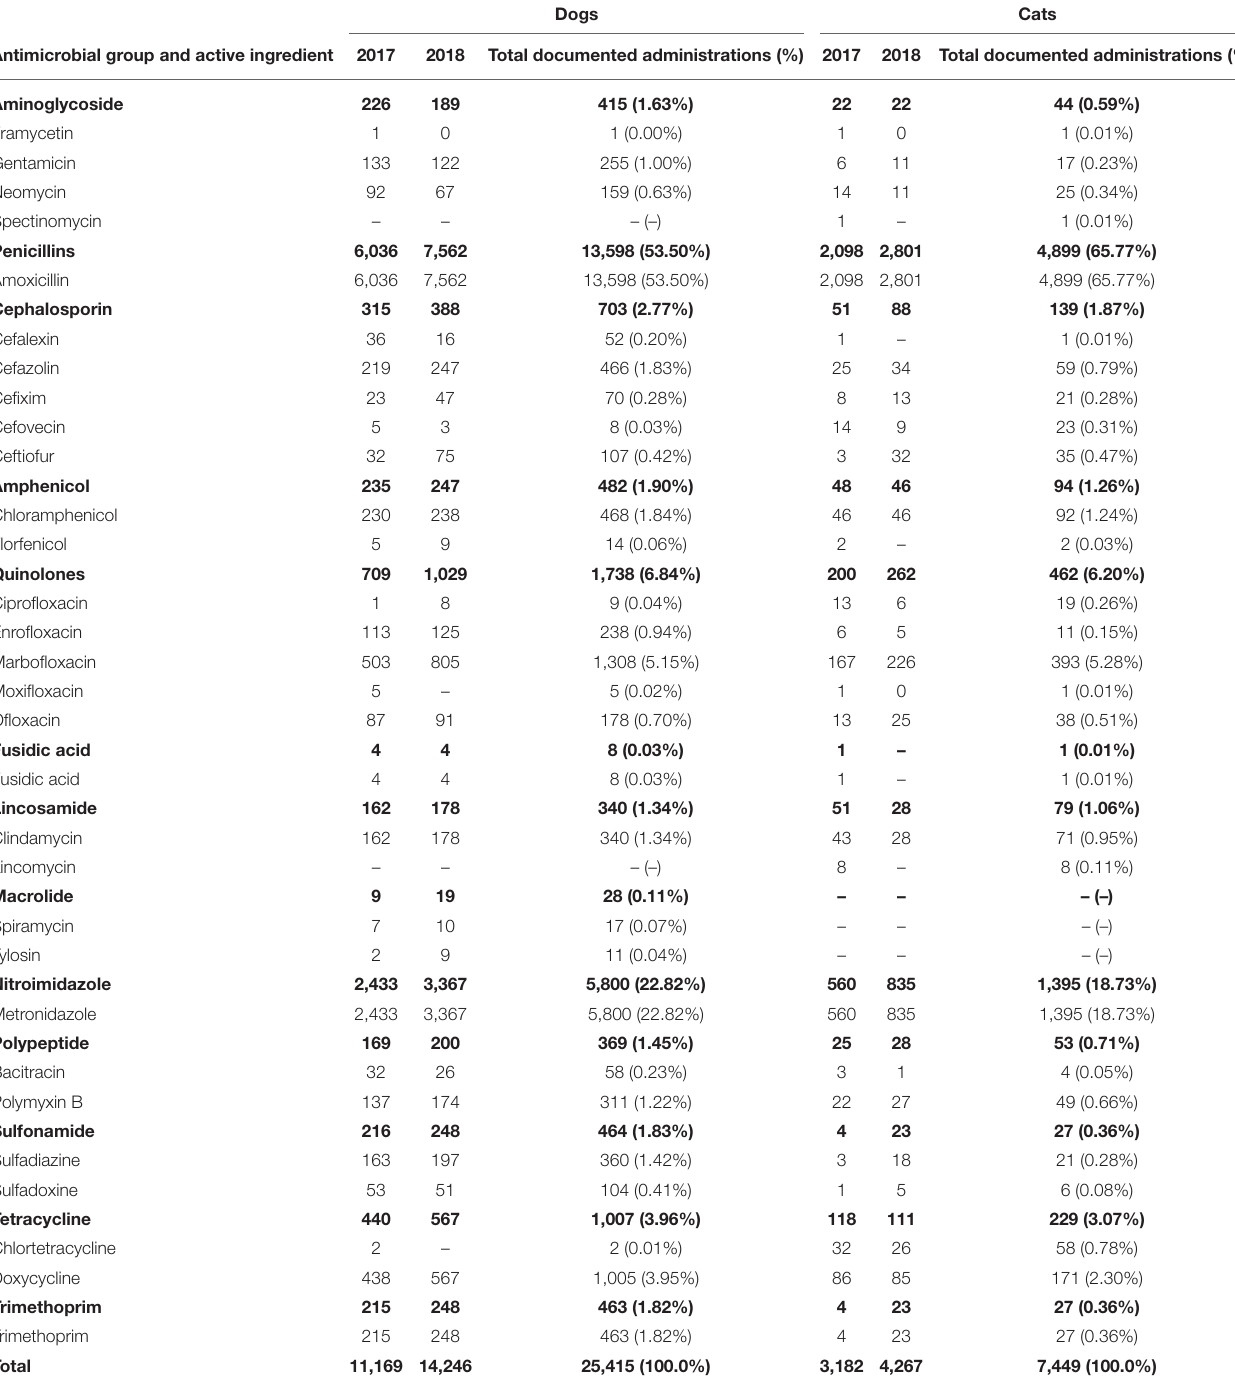
TABLE 2 | Documented number of antimicrobial active ingredients used in dogs and cats in 2017 and 2018 at the Department of Small Animal Medicine and Surgery, University of Veterinary Medicine Hannover. Dogs Cats Antimicrobial group and active ingredient